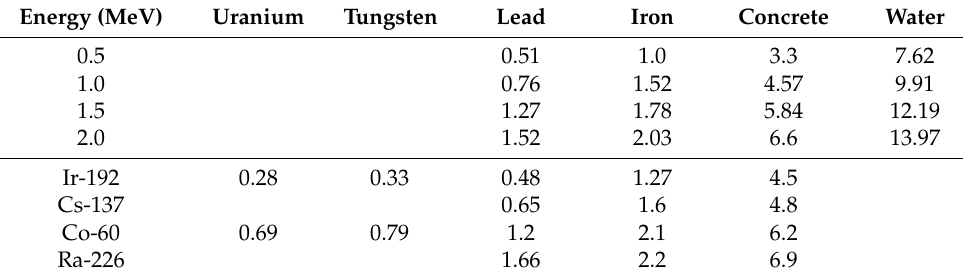
Table 2. Approximate Half Value Layers in cm.